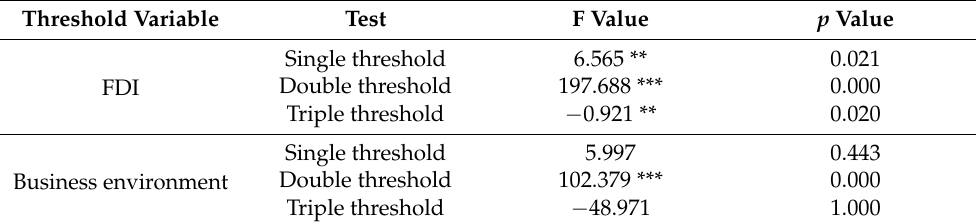
Table 6. Threshold Test and estimation results.